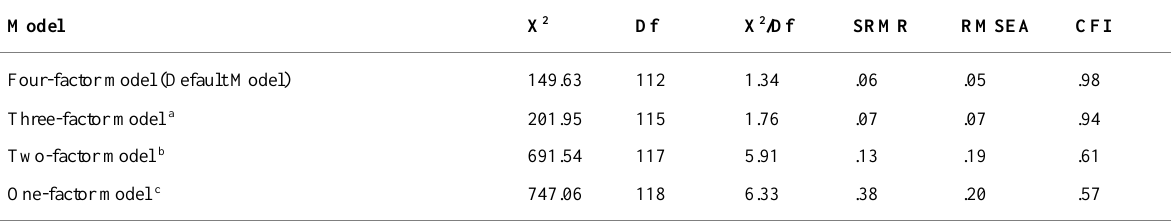
Table 1: Model Fitness Statistics